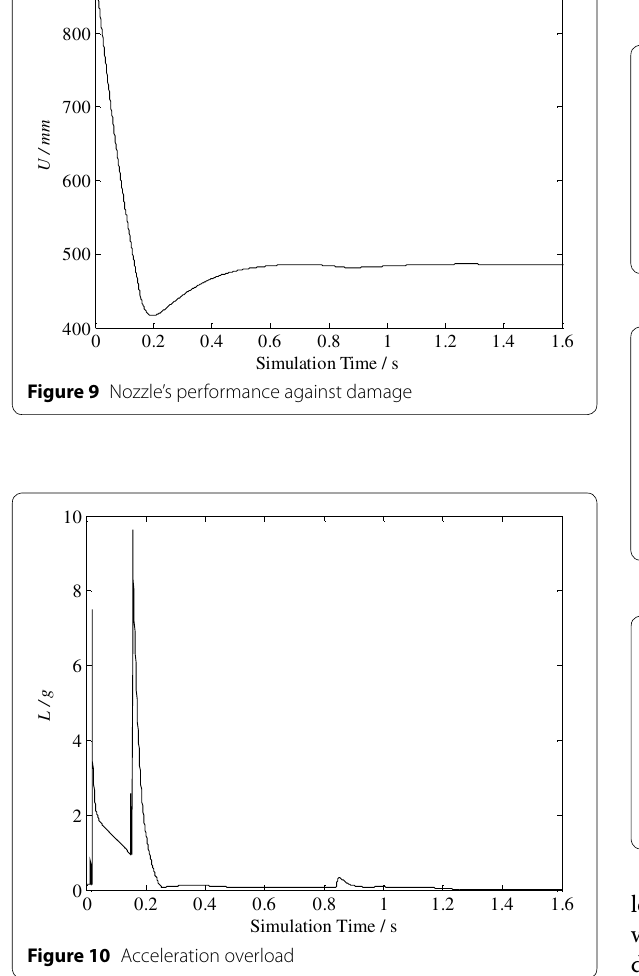
Figure 10 Acceleration overload